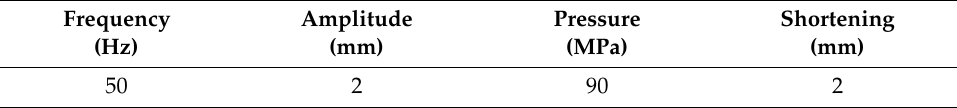
Table 3. Process parameters used for linear friction welding (LFW) of Ti-64 to